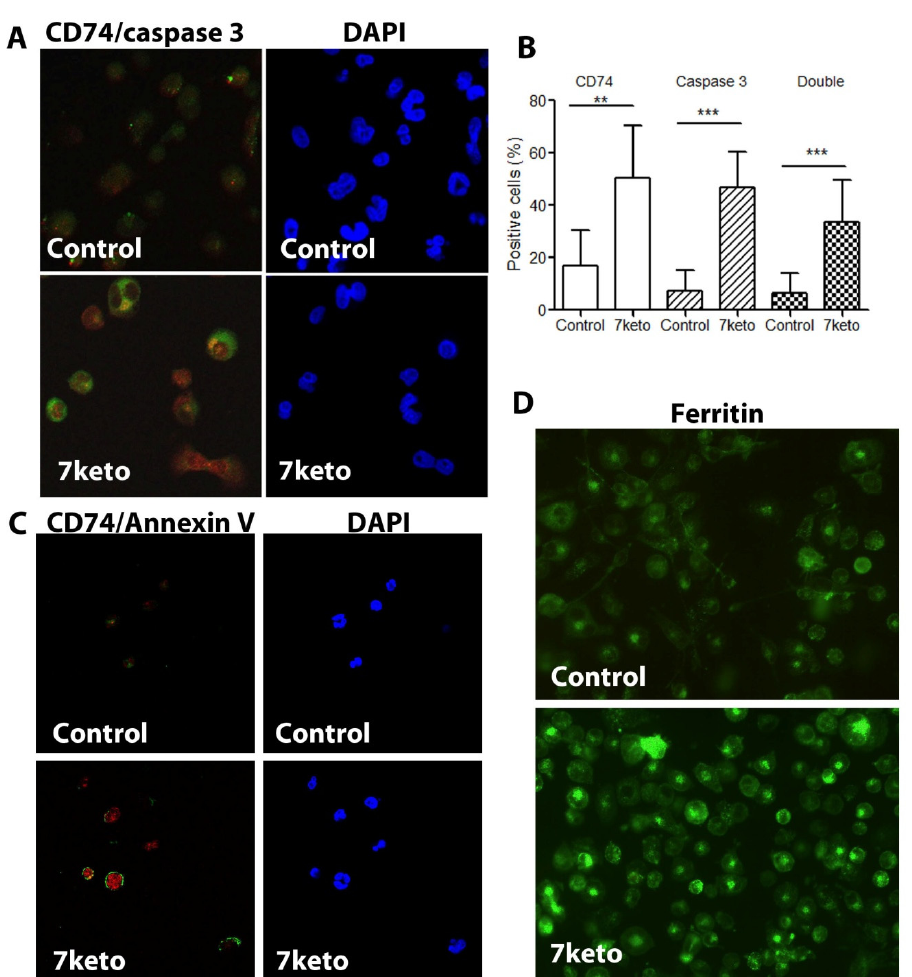
Figure 6. Increased CD74 following 7keto exposure is associated with increased ferritin and apoptotic cell death. THP-1 macrophages were either untreated or treated with 7keto for 24 h. Following double immunocytochemistry for intracellular CD74 and active caspase 3, the cells were examined by confocal microscopy. The percentage of positive cells for CD74, caspase 3, and CD74 with caspase 3 were counted. ( A ) Representative photographs of CD74 (red) and caspase 3 (green). Nuclei stained blue with DAPI. ( B ) Positive cells with intracellular CD74 and caspase 3 (%). Data are mean ± SD, n = 8–9. ** p < 0.01 and *** p < 0.001. ( C ) Representative photographs of CD74 (red) and Annexin V (green) in control and 7keto ‐ treated cells. Nuclei stained blue with DAPI. ( D ) Representative photographs of ferritin immunocytochemistry in control cells and 7keto ‐ treated cells.